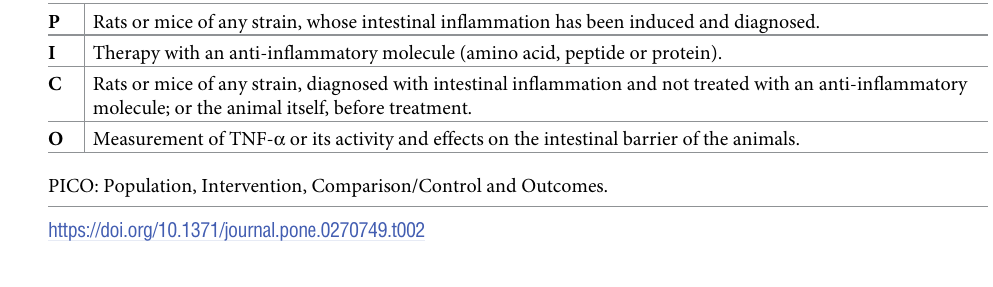
Table 2. PICO strategy used to select articles to compose the systematic review, aiming to answer the question: What are the mechanisms of action of molecules with anti-TNF- α activity on the intestinal